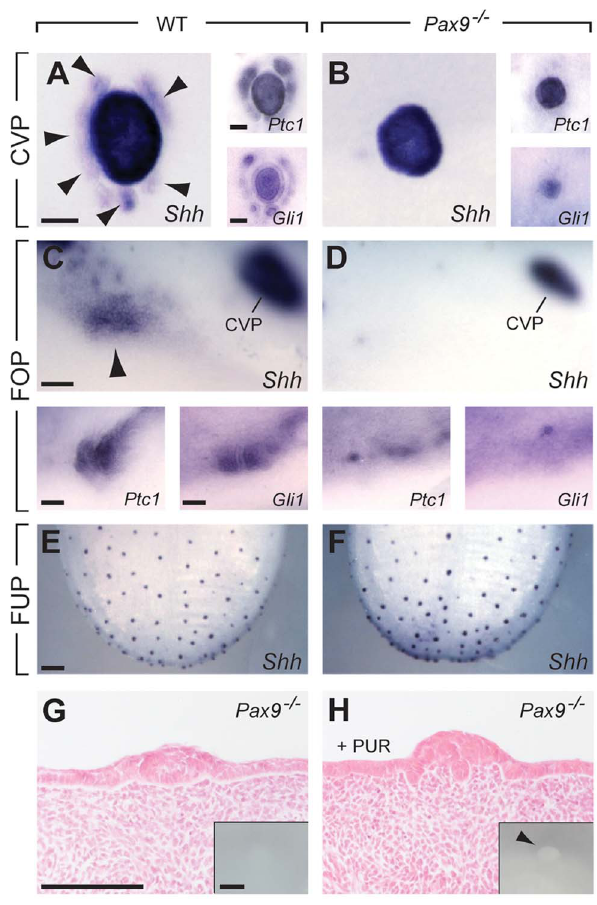
Figure 5. Absence of Pax9 causes an endoderm-specific disruption of the Shh pathway in taste papillae. ( A–F ) Whole mount in situ hybridization of Shh , its receptor ( Ptc1 ) and the downstream effector transcription factor ( Gli1 ) at E14.5. ( A,B ) In the wild type CVP (A), Shh is expressed in the central dome as well as in a ring of accessory papillae (arrowheads). Ptc1 and Gli are expressed in a similar pattern. In the absence of Pax9 , Shh , Ptc1 and Gli1 are only expressed in the central dome of the CVP (B). ( C,D ) In wild type embryos (C), patches of Shh , Ptc1 and Gli1 expression are detectable in the region of the developing FOP, whereas these expression patterns are missing ( Shh ) or are greatly reduced ( Ptc1 , Gli1 ) in Pax9 2 / 2 embryos (D). ( E,F ) Shh expression in FUP placodes is similar in wild type (E) and Pax9 -deficient (F) embryos. ( G, H ) Histological sections of Pax9 - deficient, cultured embryonic tongues. (G) In control medium the Pax9 2 / 2 CVP of cultured tongues is small and is not visible externally (inset). (H) In the presence of purmorphamine (PUR) the number of epithelial cells is increased in the dome of the CVP. Note the absence of trenches. Inset shows enlarged, protruded CVP dome (arrowhead) of the cultured tongue. Scale bars: 100 m m in A,C,G: 200 m m in E.